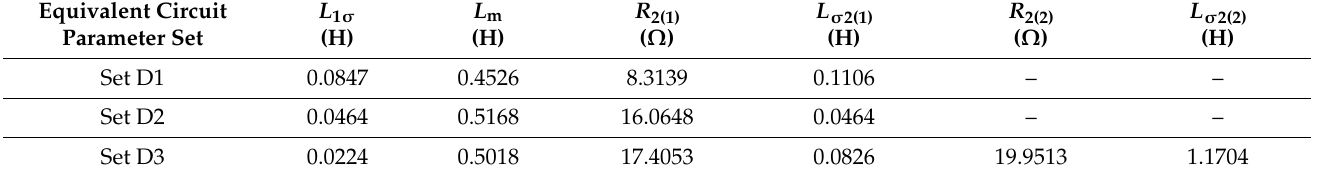
Table A3. The equivalent circuit parameter sets of the tested SR IM. The individual resistances correspond to the average stator winding temperature of 52 ◦ C registered under the load curve test.